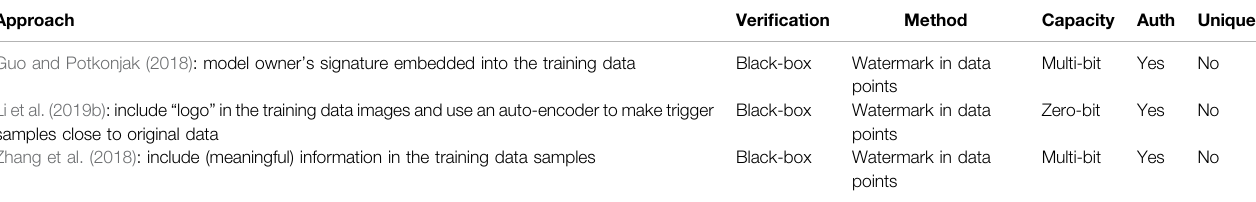
TABLE 4 | Techniques to embed watermarks into the training data in order to create the trigger dataset. Approach